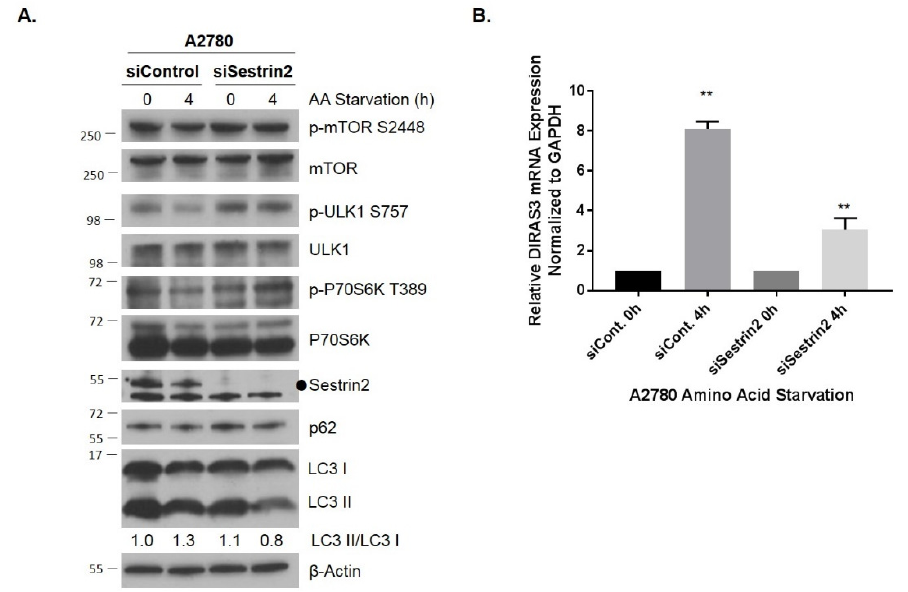
Figure 3. Knockdown of Sestrin2 inhibits amino acid starvation-induced mTOR inhibition, autophagy and upregulation of DIRAS3. A2780 cells were reversely transfected with control or Sestrin2 siRNA for 72 h prior to undergoing amino acid deprivation for 0–4 h. ( A ) Protein lysates were collected and western blot analysis was performed. Blots were probed as indicated. ( B ) qRT-PCR was performed and DIRAS3 mRNA was measured relative to GAPDH. The experiment was performed three independent times with technical duplicates. Bars indicated the mean ± the standard deviation; ** p < 0.01. Raw data films for western blot analysis shown in Figure